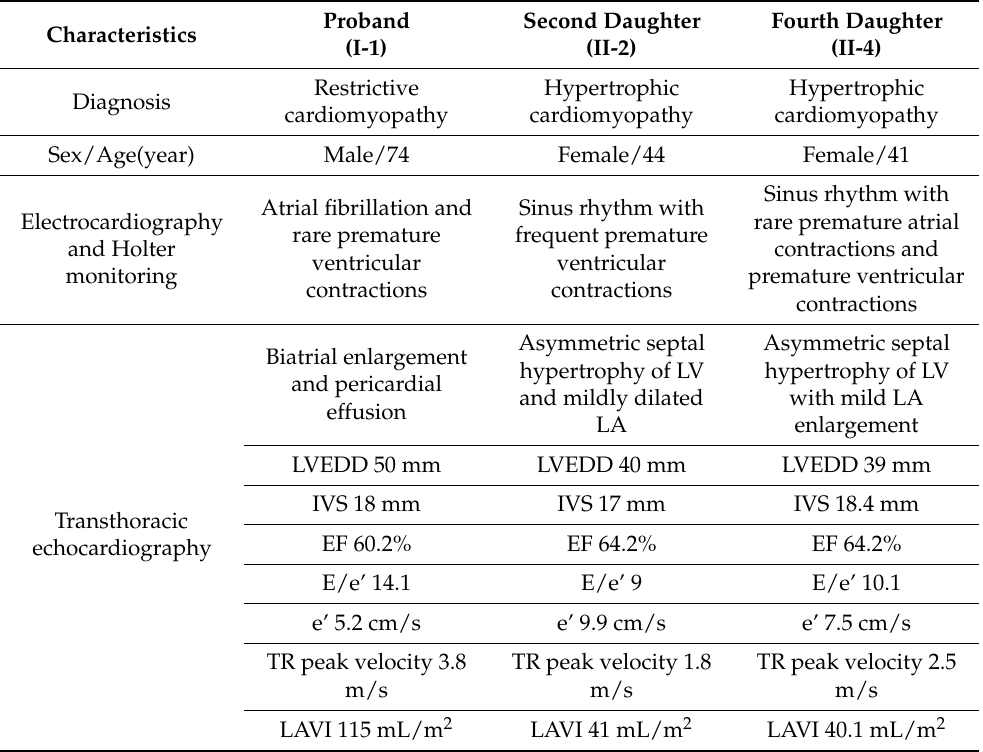
Table 1. Clinical characteristics of individuals diagnosed as different cardiomyopathy with heterozy- gous MYBPC3 frameshift